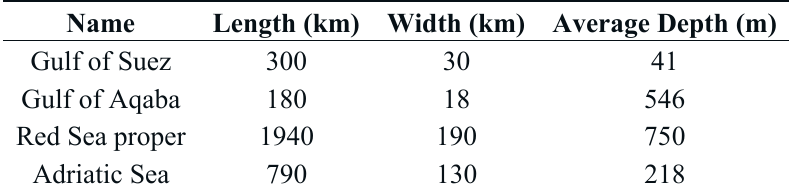
Table 1. Dimensions of seas and gulfs. The average depths are calculated by averaging all SRTM30 grid points below sea level. The Red Sea proper is south of the Sinai Peninsula and the Straits of Tiran. The modeled Red Sea domain extends south only to 25° North latitude.